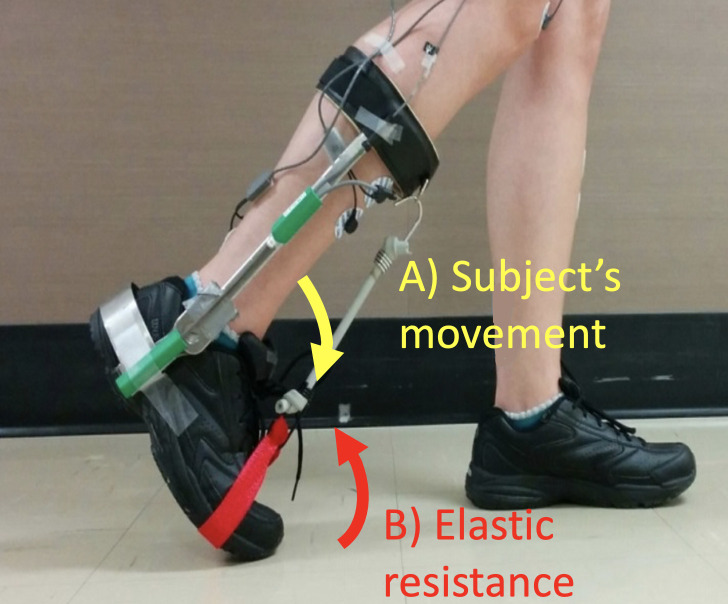
Picture of the modified AFO with the elastic force field on.A picture of the modified Klenzac ankle foot orthosis representing the subject’s movement (A) recorded by the electrogoniometer placed on the lateral stem of the modified AFO and the elastic resistance that participants had to resist (B).